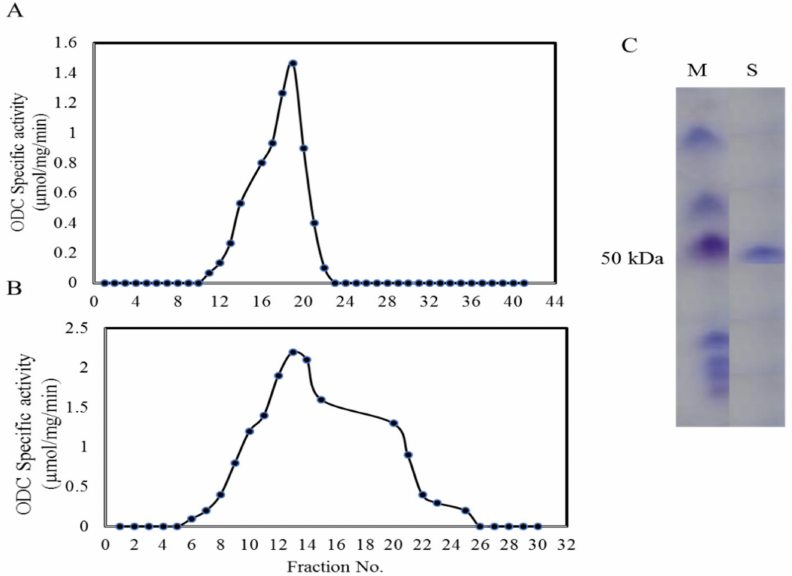
Figure 3. PurificationofODCfromthecultureof A.terreus. ThecrudeODCwasextractedfromtheculturesof A. terreus , concentrated by dialyzer, purified by ion-exchange and gel-filtration chromatography. The pattern of ODC purification by ion-exchange chromatography ( A ), and gel-filtration chromatography ( B ). SDS-PAGE pattern for the subunit structure of purified A. terreus ODC ( C ). M, protein Marker (Cat. # PG-PMT2962, 315-10 kDa), S, purified ODC sample after the last purification